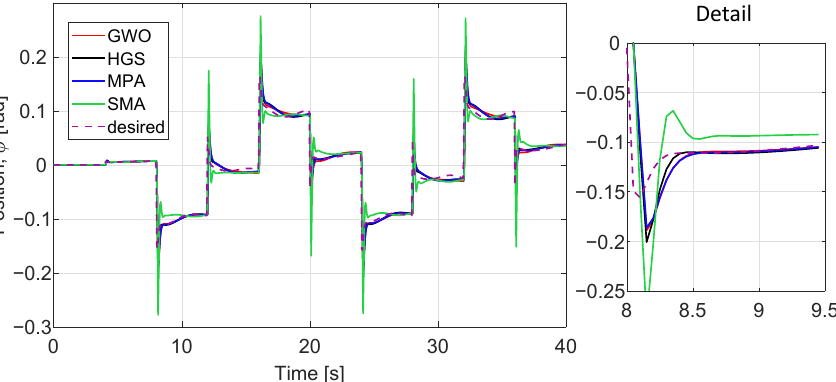
Figure 19. Comparison of tracking performance in φ –angle of the different algorithms evaluating parameters obtained with 100 individuals.